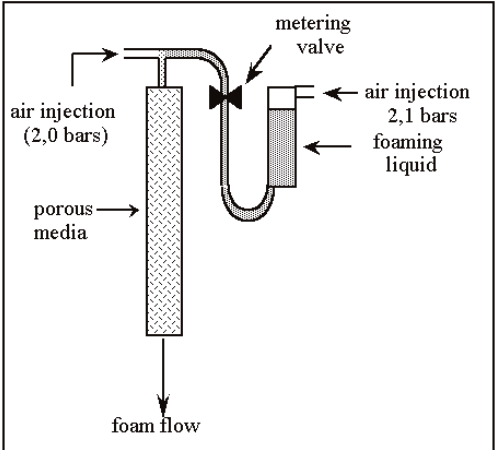
Figure 1 (left): Foam generator. Table 1 (right): Foam